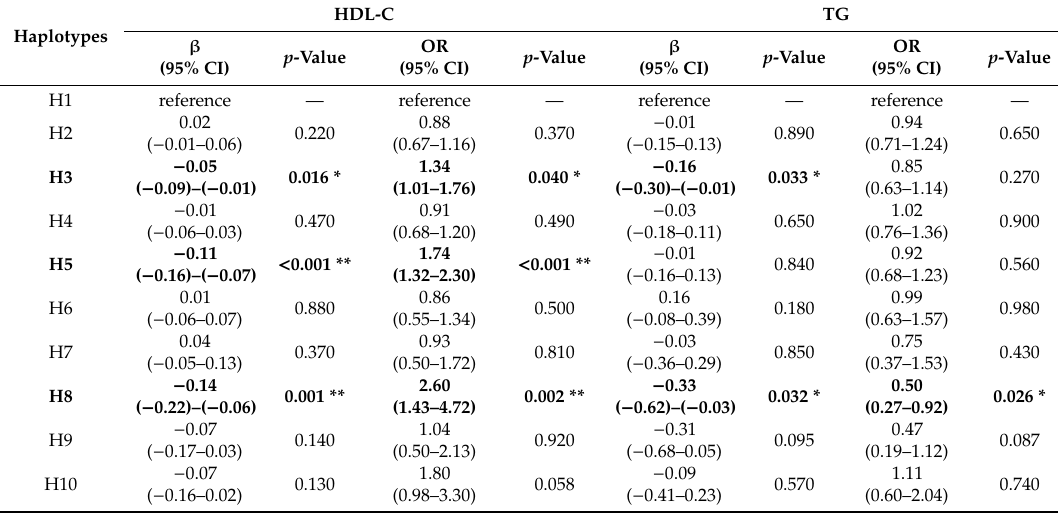
Table 4. The e ff ect of haplotypes in CETP gene on high-density lipoprotein cholesterol (HDL-C) and triglyceride (TG) levels in the combined study population (Hungarian Roma and Hungarian general together). The association was evaluated under adjusted models (ethnicity, sex, age, body mass index, systolic and diastolic blood pressure, fasting glucose level, antihypertensive, antidiabetic and lipid-lowering